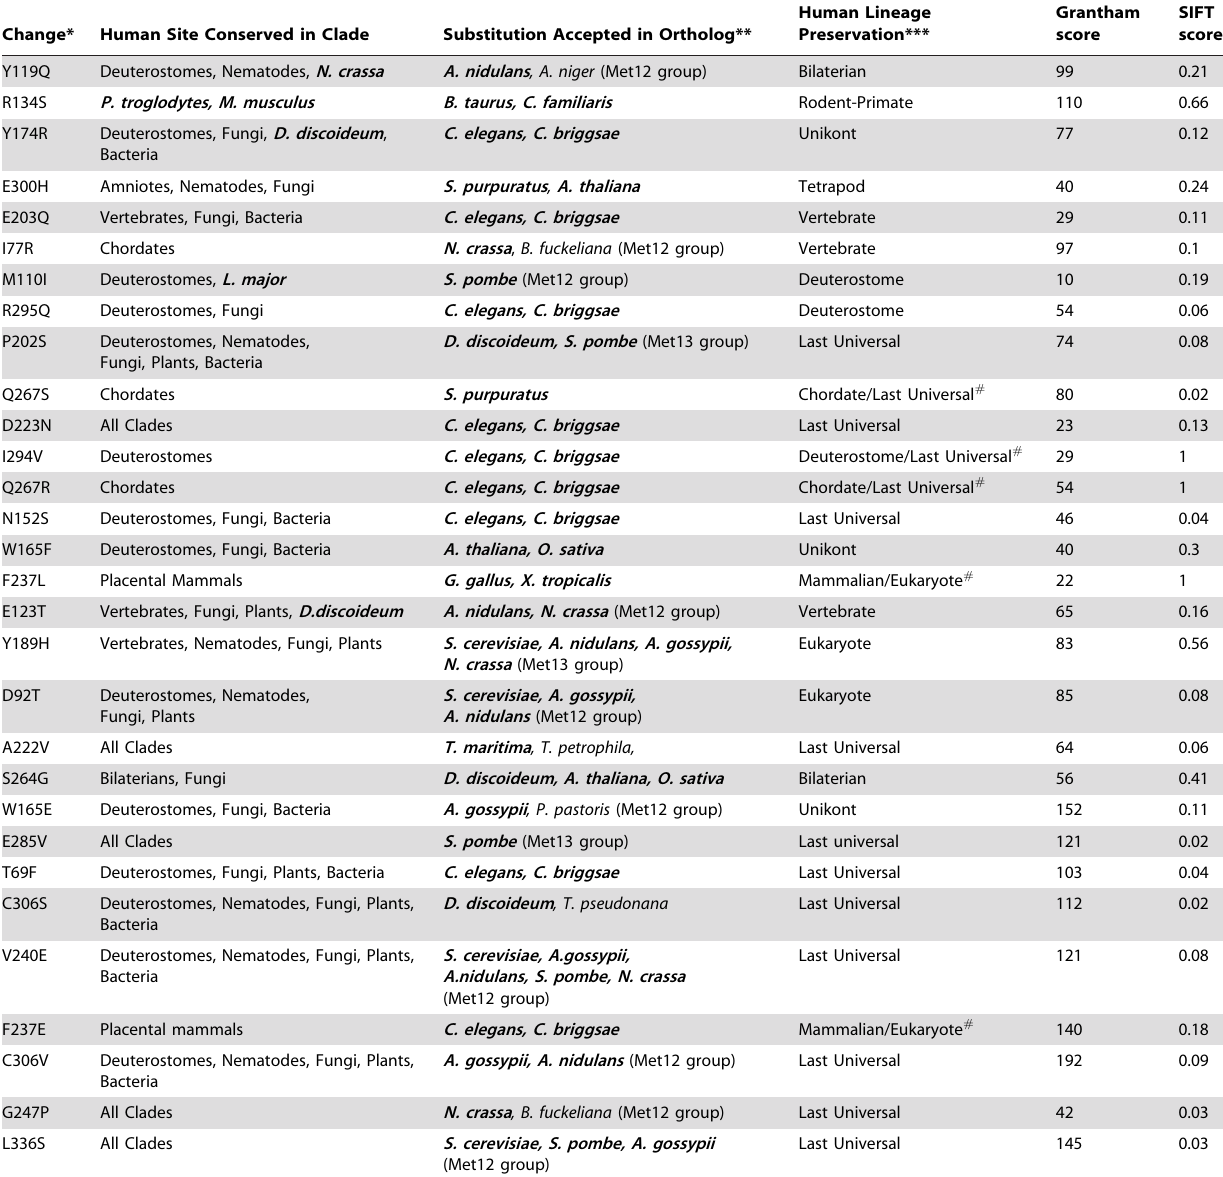
Table 1. Amino acid substitutions from human MTHFR orthologs tested for functional